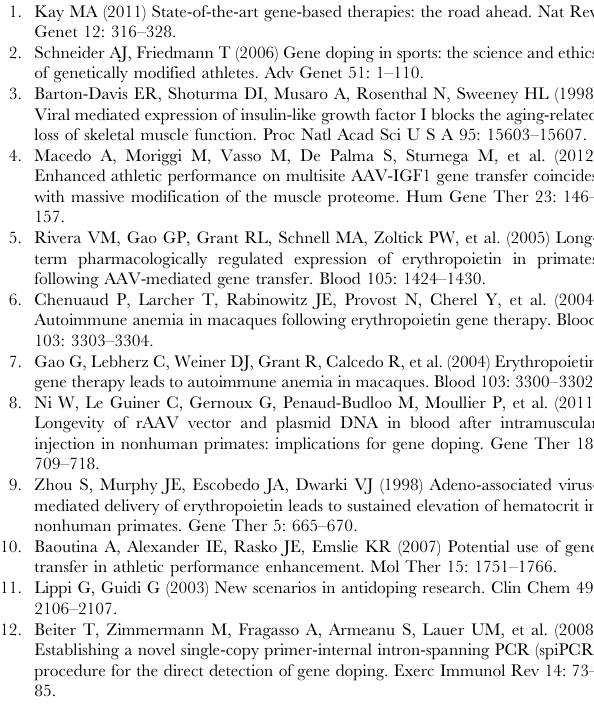
Figure S3 Temperature gradient for ddPCR detection of IGF1, EPO and ICS. Figure S4 ddPCR efficiency under various conditions. Figure S5 Qualitative assessment of ddPCR results. Figure S6 Concentration, purity and integrity of DNA comparing three different DNA extraction procedures. Table S1 IGF1 transgene copy numbers as detected by ddPCR for 6 AAV9-IGF1 transduced mice and 2 controls at 5 different